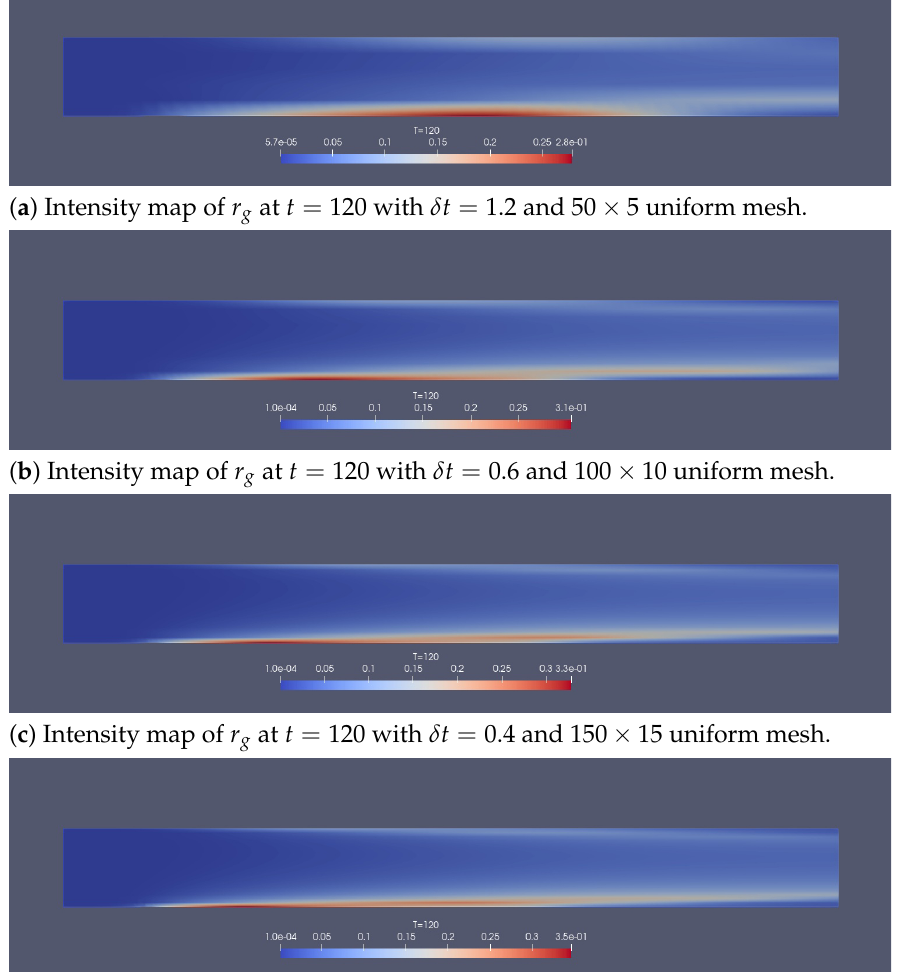
( d ) Intensity map of r g at t = 120 with δ t = 0.3 and 200 × 20 uniform mesh. Figure 11. For Section 5.2: The intensity maps of r g for different time step and mesh size pairs.